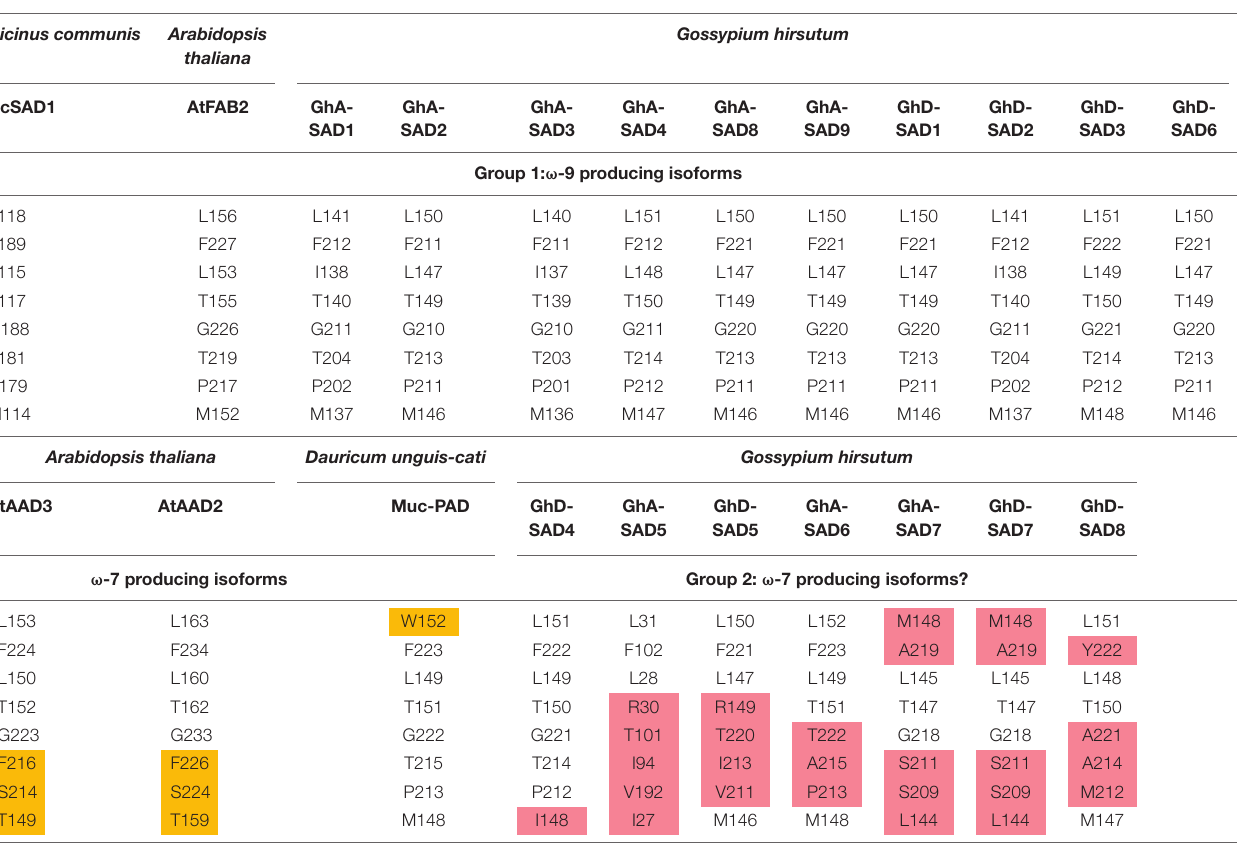
TABLE 1 | Comparison of the eight amino acid residues comprising the region of the catalytic sites of GhSADs. Ricinus communis